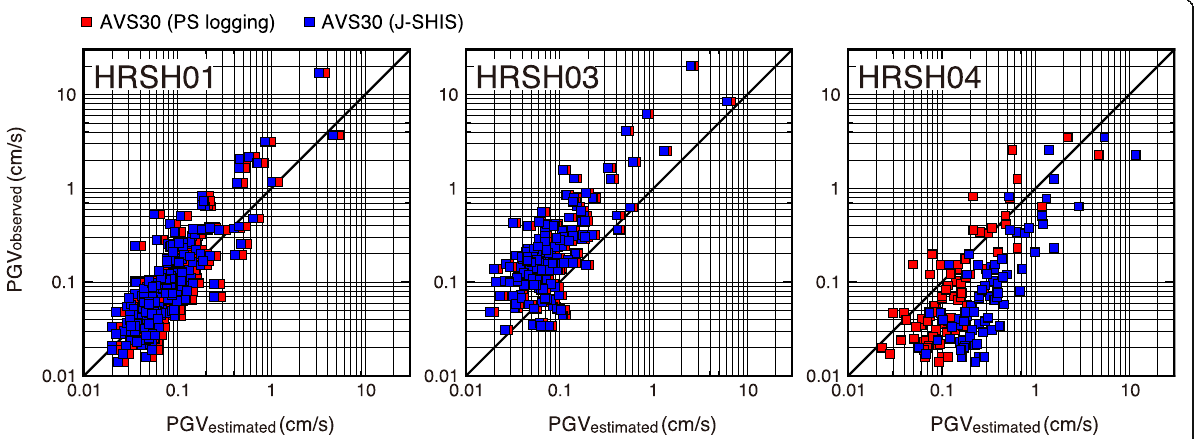
Fig. 13 Comparisons between observed (vertical axes) and estimated (horizontal axes) peak ground velocities (PGVs) at three KiK-net stations (HRSH01, HRSH03, HRSH04) in Hiroshima Prefecture for earthquakes in the magnitude range from 3.4 to 7.1, from 1998 to 2017. The estimated PGVs are derived using the GMPE by Si and Midorikawa (1999) that is used in the EEW scheme of JMA. Here, the site amplification coefficients are derived using AVS30 values based on PS logging at each Kik-net station (red squares) and nationwide site amplification map, J-SHIS (blue squares), respectively (see the AVS30 values in Table 2). The diagonal indicates a one-to-one proportional